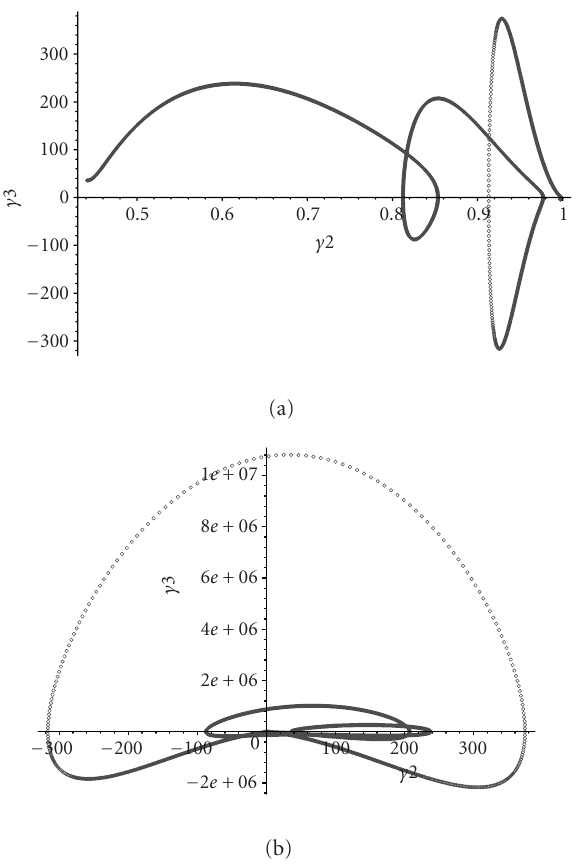
Figure 5.12. Showing ˙ ε versus ε and ¨ ε versus ˙ ε , we have changed the initial conditions and found a similar